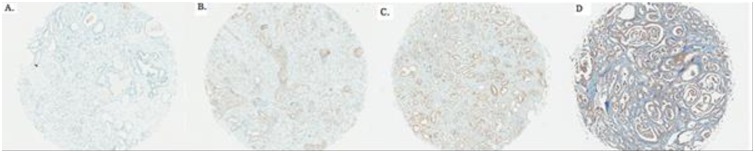
Representative immunohistochemical staining of prostate stem cell antigen (PSCA) in prostatectomy specimens of prostate cancers.Immunohistochemistry shows strong PSCA staining in the neoplastic epithelium from grades 0 to 3.